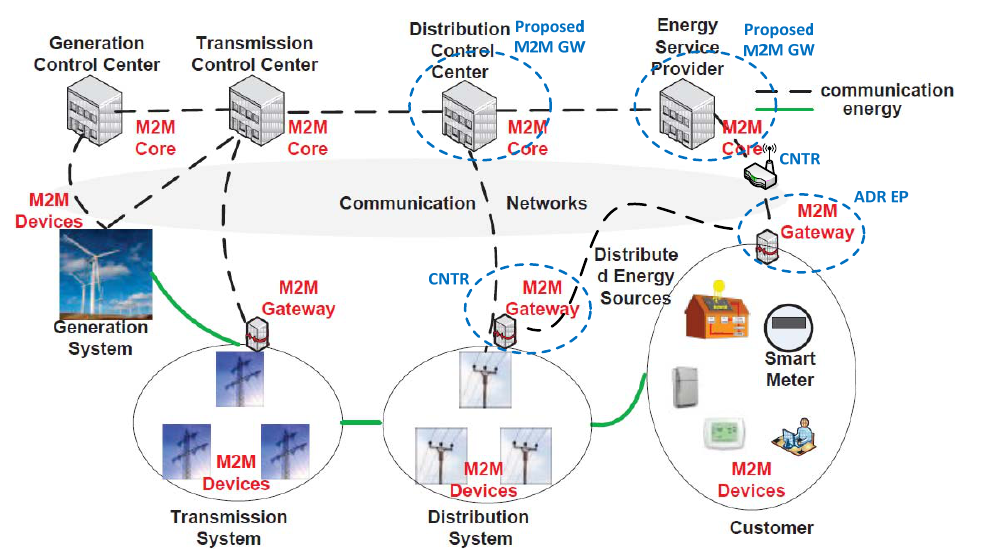
Table 1, the scope of the proposed system is bounded to the Customer, Distribution, Service Provider, and Operations domains.